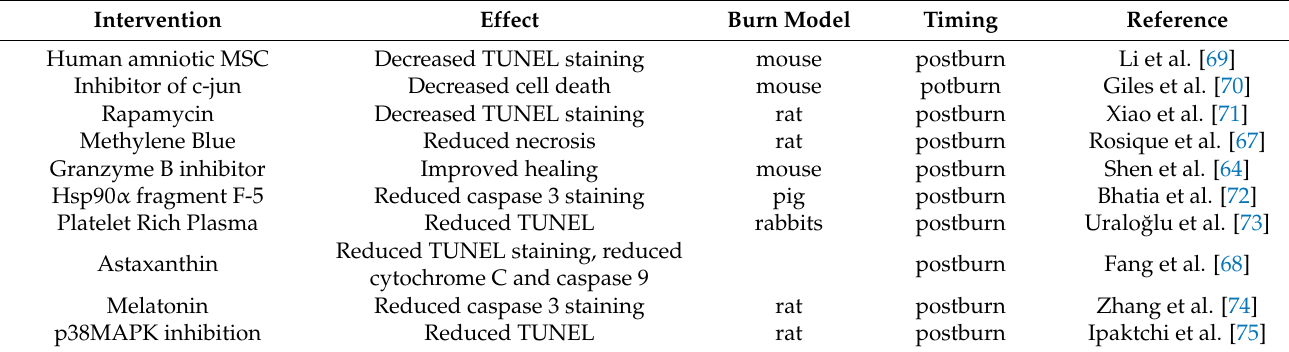
Table 1. Postburn interventions aimed at reducing thermally induced apoptosis.